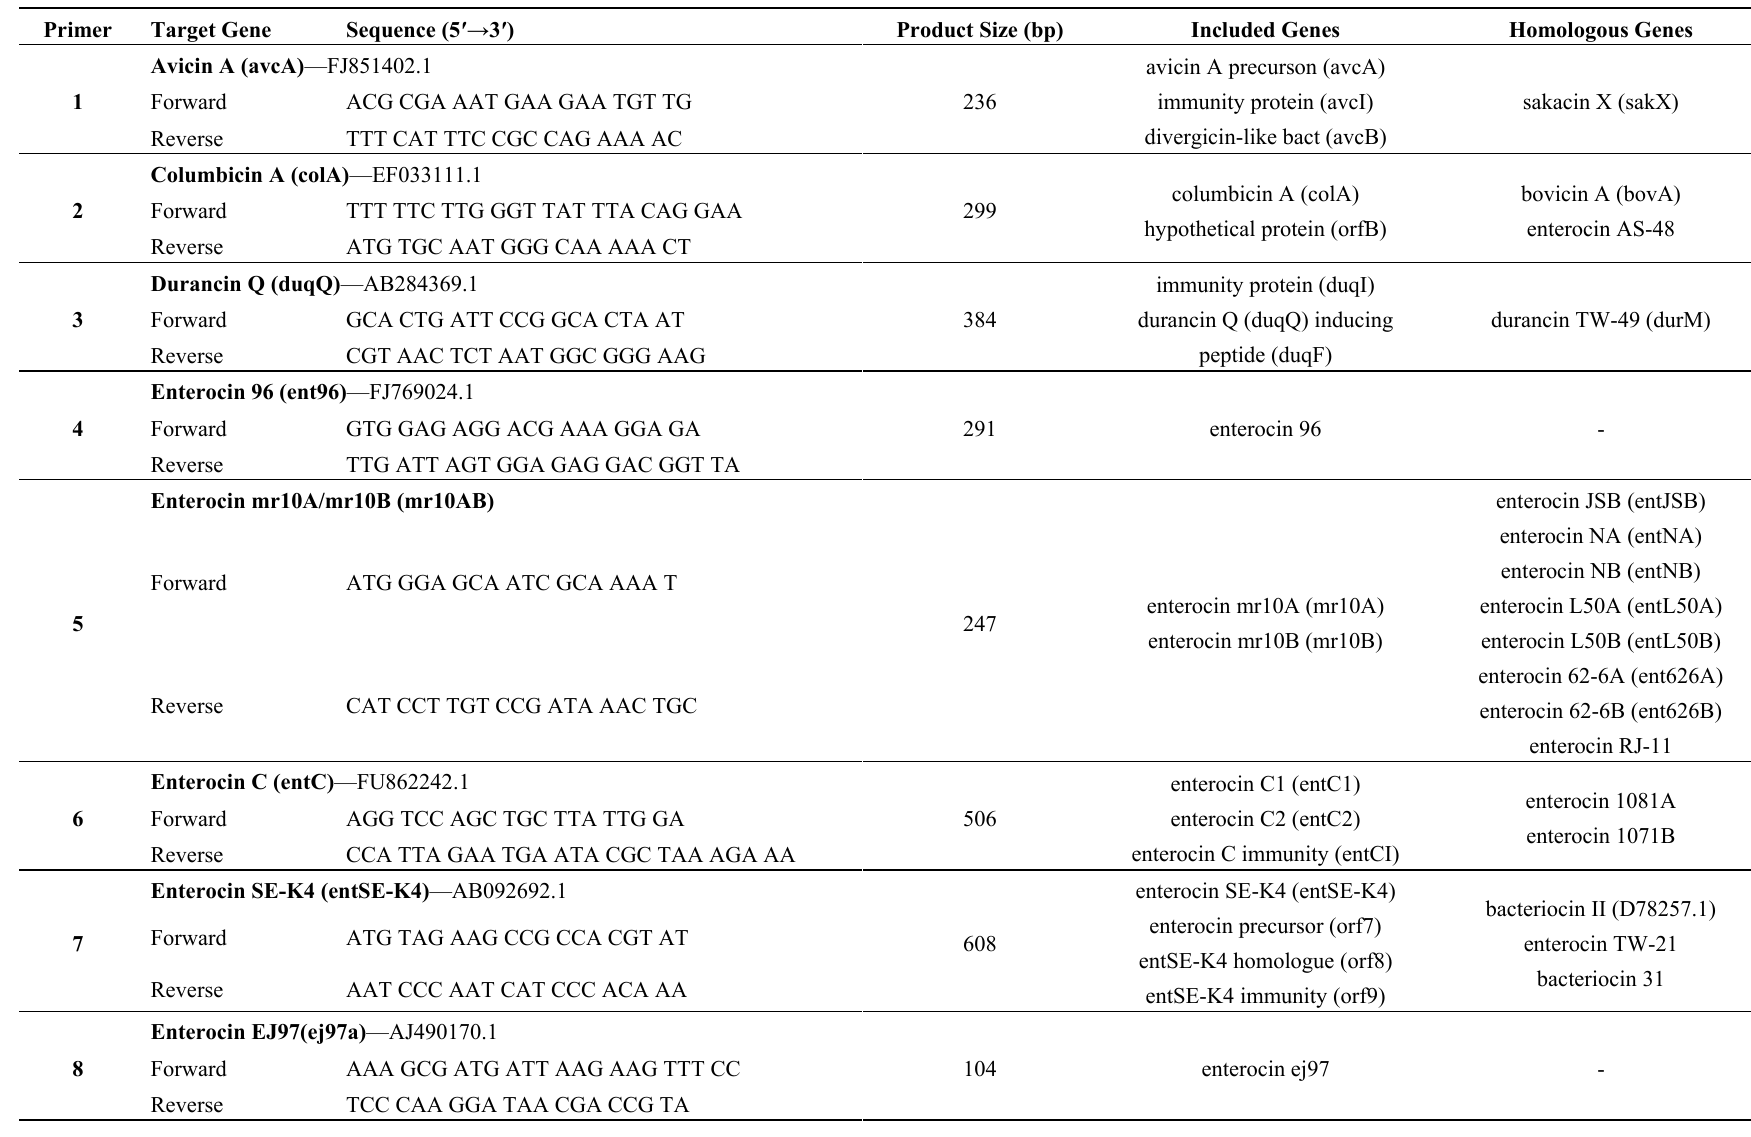
Table 1. Bacteriocin-related primer sequences used in this